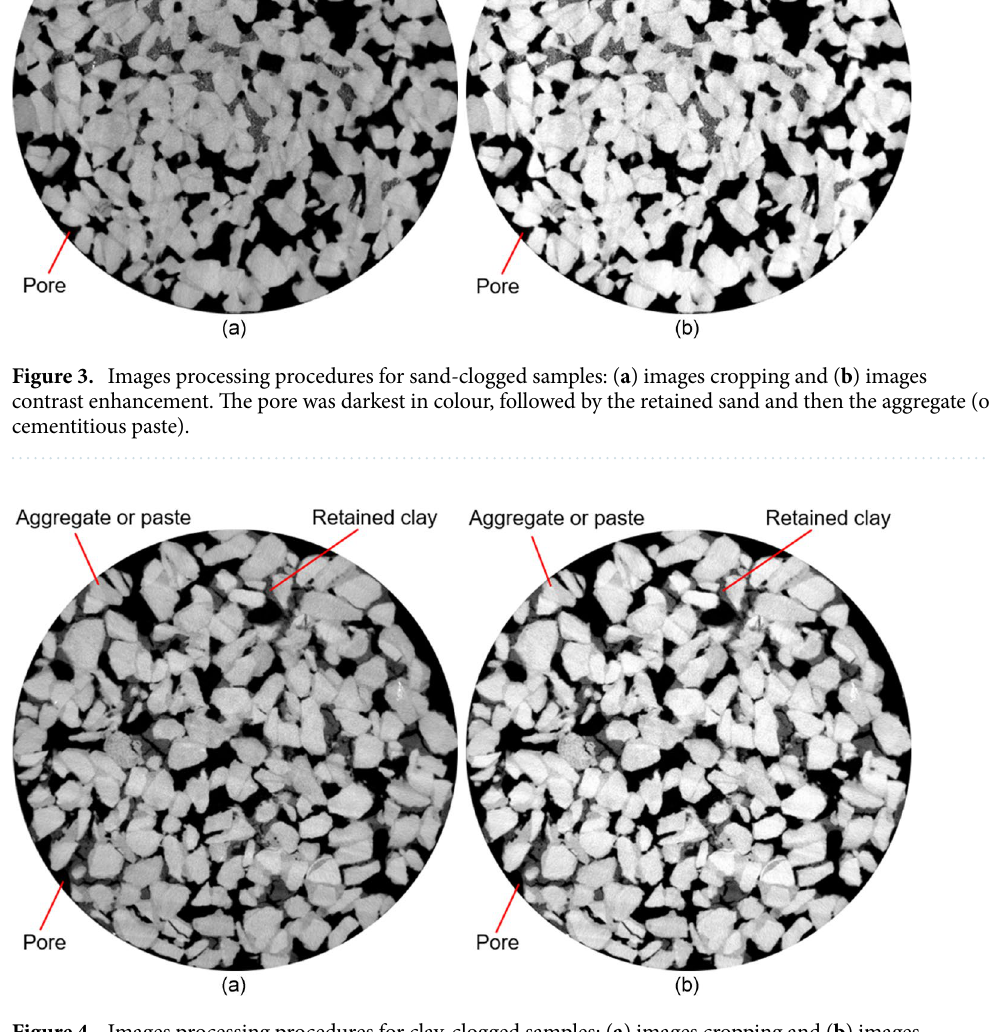
Figure 4. Images processing procedures for clay-clogged samples: ( a ) images cropping and ( b ) images contrast enhancement. The pore was darkest in colour, followed by the retained clay and then the aggregate (or cementitious